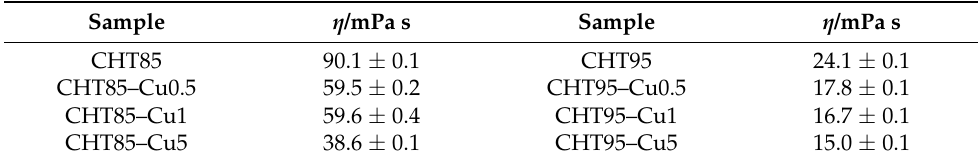
Table 3. Dynamic viscosity of pure chitosan solutions (CHT85 and CHT95) and CHT–Cu 2+ complex